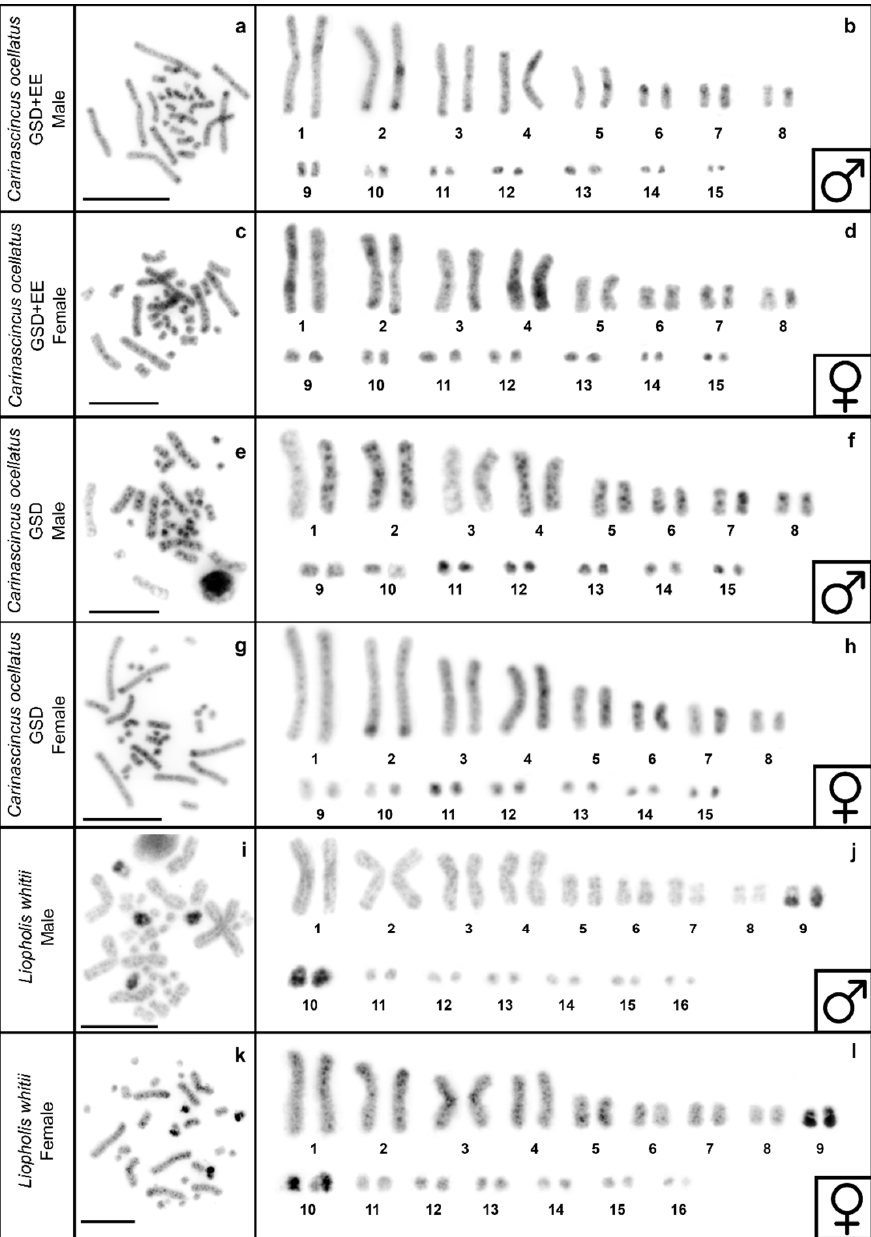
Figure 5. C-banded spread and karyotypes in GSD+EE (low elevation) Carinascincus ocellatus male ( a,b ) and female ( c,d ), GSD (high elevation) C. ocellatus male ( e,f ) and female ( g,h ) and Liopholis whitii male ( i,j ) and female ( k,l ). Scale bar represents 10 µm.